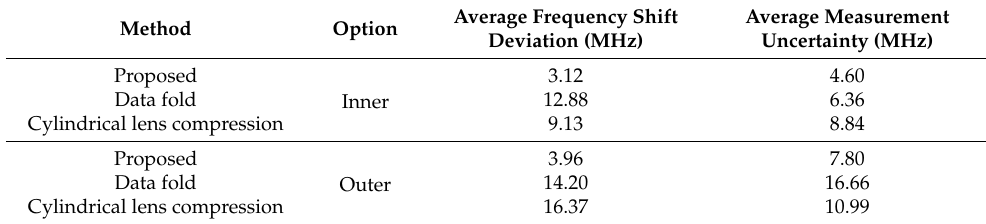
Figure 12. Distribution diagram of inner and outer rings. Table 3. Comparison of experimental results using different methods.